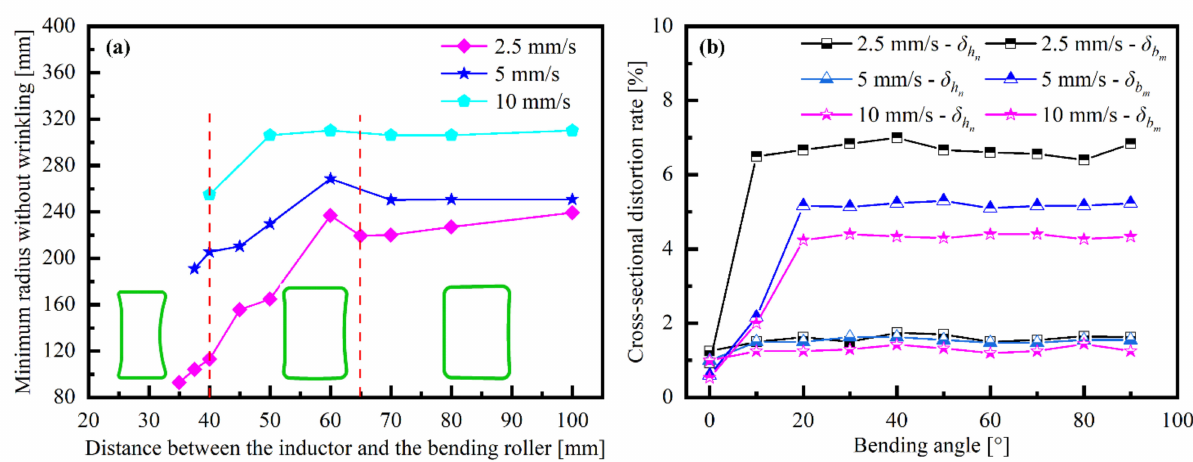
Figure 22. Experimental results with different feed rates of the tube: ( a ) Minimum radius with different distances between the inductor and the bending roller; ( b ) Cross-sectional distortion rate at different bending angles (distance between the inductor and the bending roller: 50